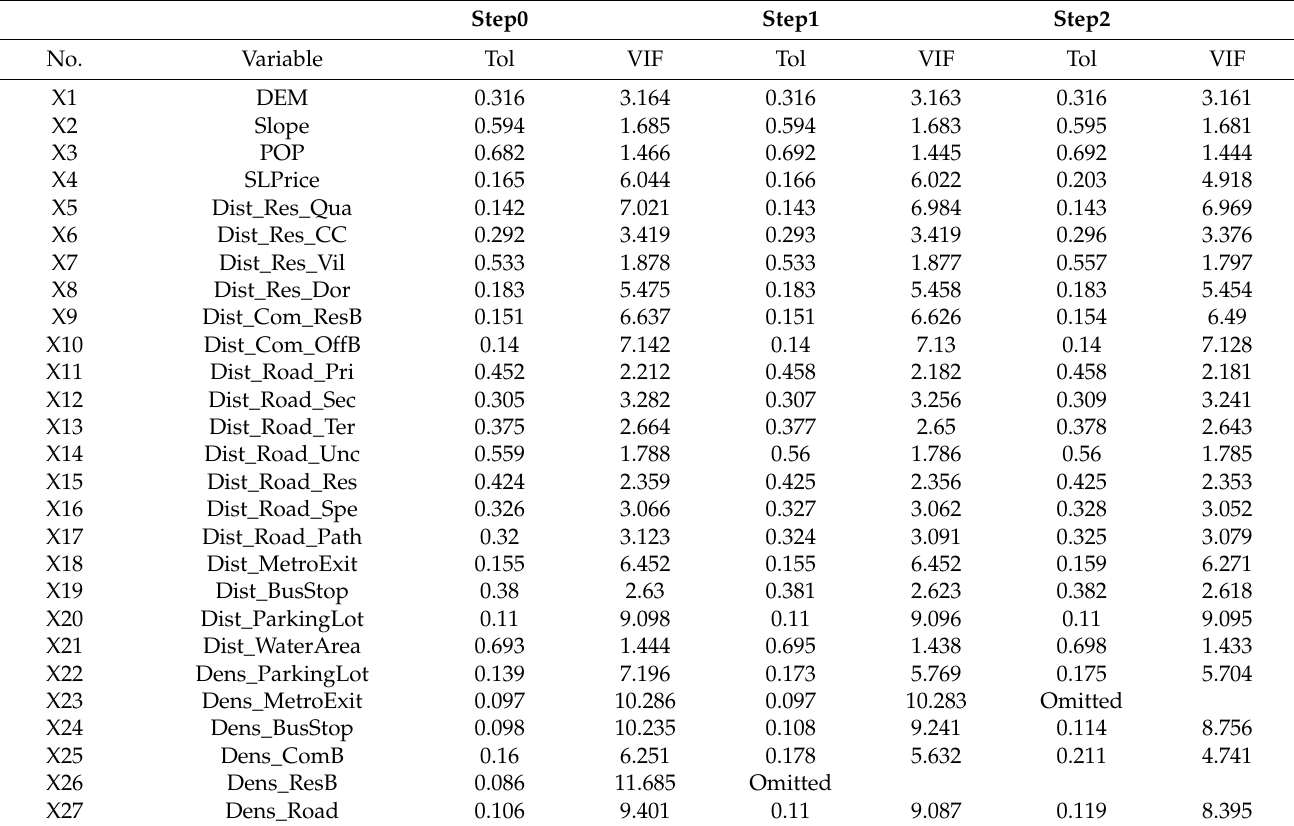
Table 5. VIF values of all variables after omitting the variable with the multicollinearity problem. Step0 Step1